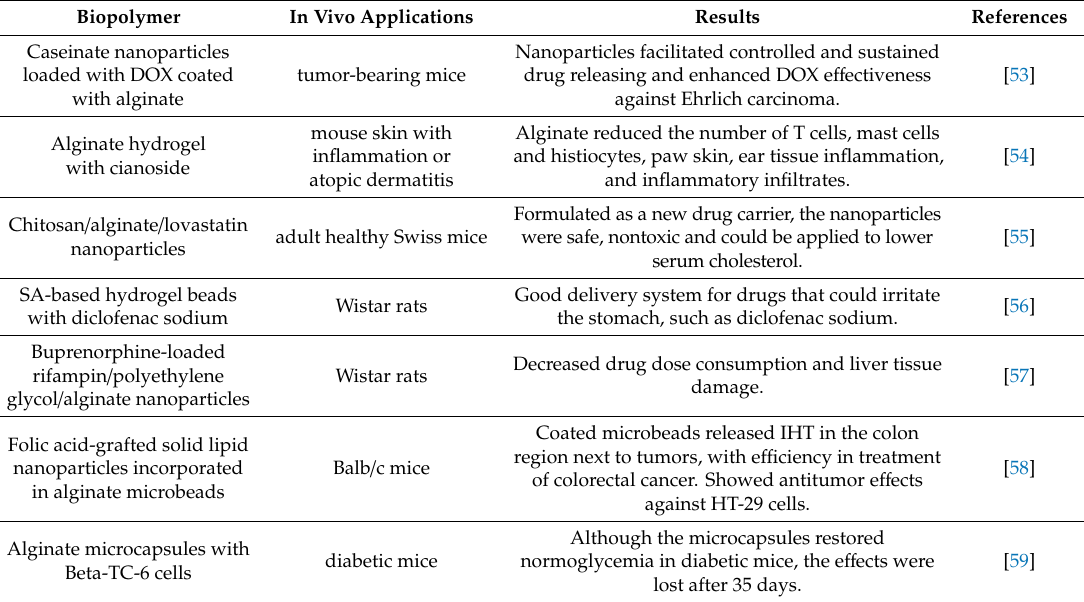
Table 2. E ff ects of alginate in